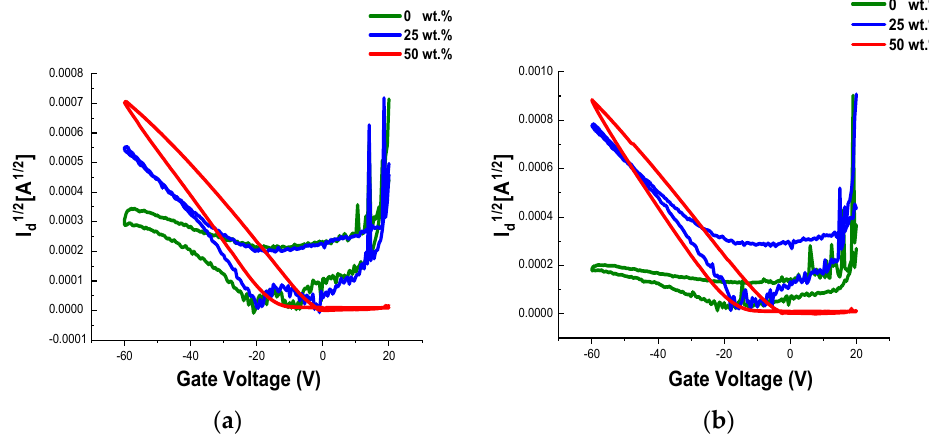
Figure 4. Transfer curves of OFET devices prepared from 0 to 50 wt.% LPE:P(DPPTVT) after stretching at 25% elongation and measured parallel ( a ) and perpendicular ( b ) to the device channel. The gate voltage was scanned from 20 to − 60V at V d = − 60V .